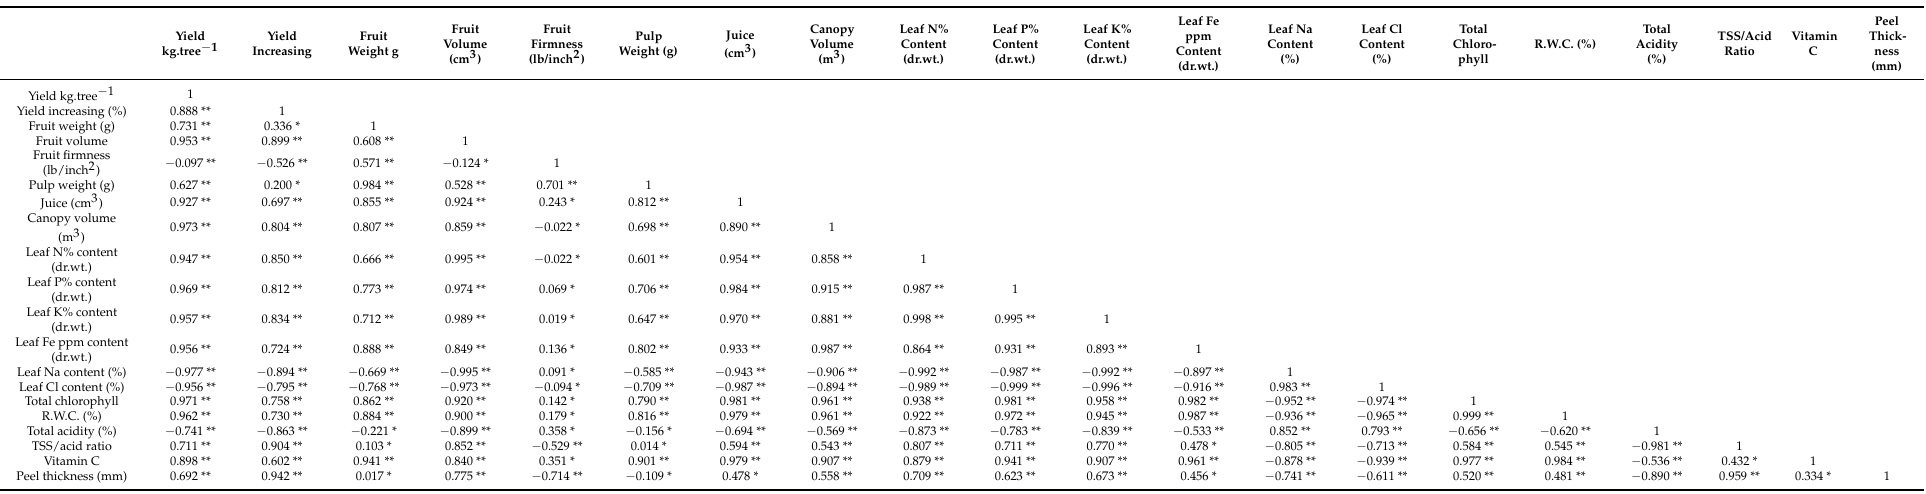
Table 3. Correlation analysis of the measured parameters of the effect of magnetic iron application on fruit physicochemical properties of ‘Chinese’ mandarin trees during